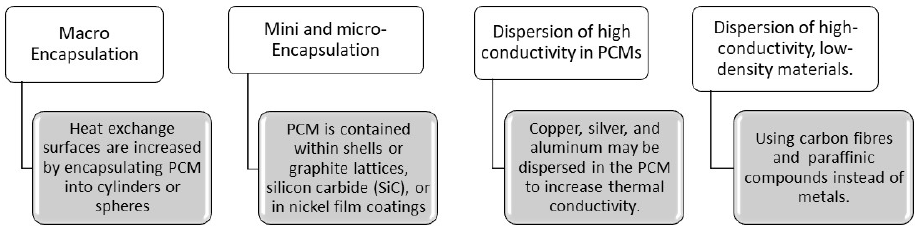
Figure 2. The main techniques to improve the heat transmission of PCMs.